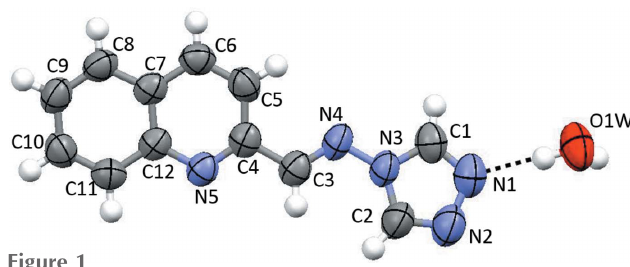
Figure 1 The molecular structure of the title compound, showing the atom- labelling scheme and 50% probability displacement ellipsoids.